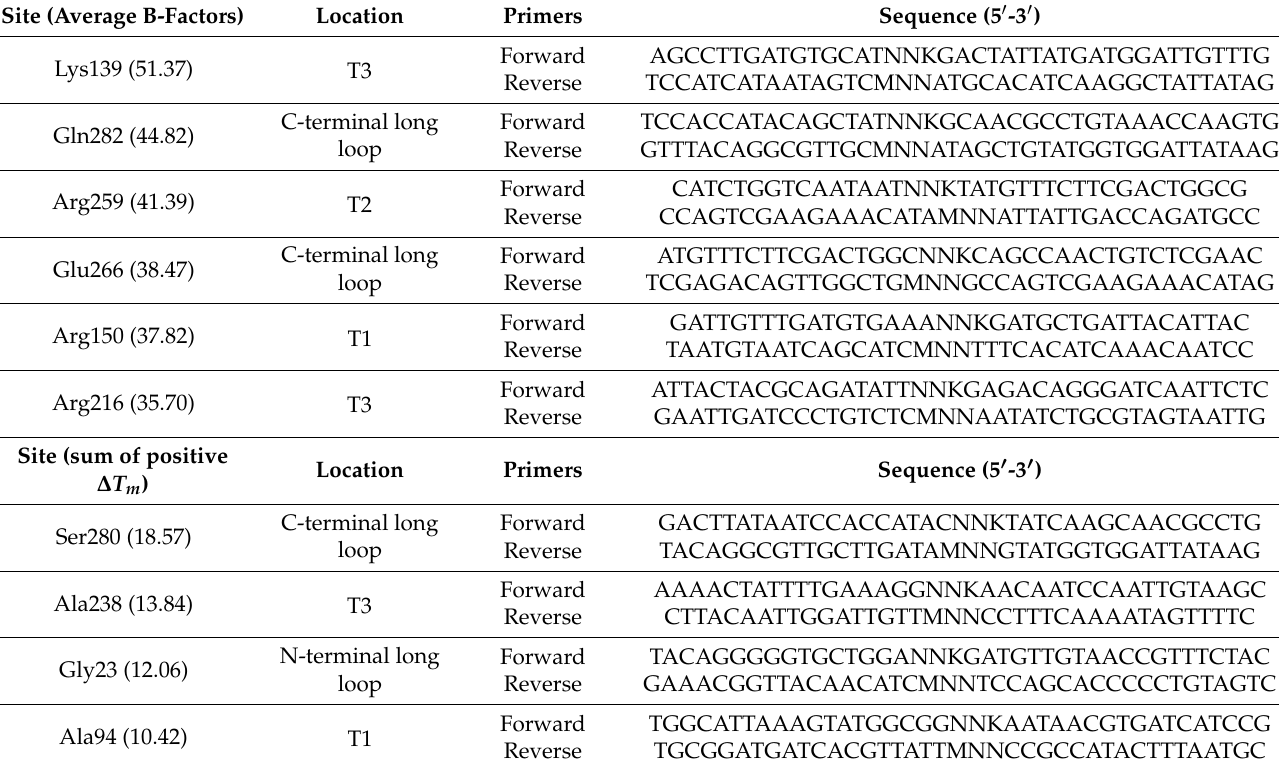
Table 2. Mutation sites and primers used for